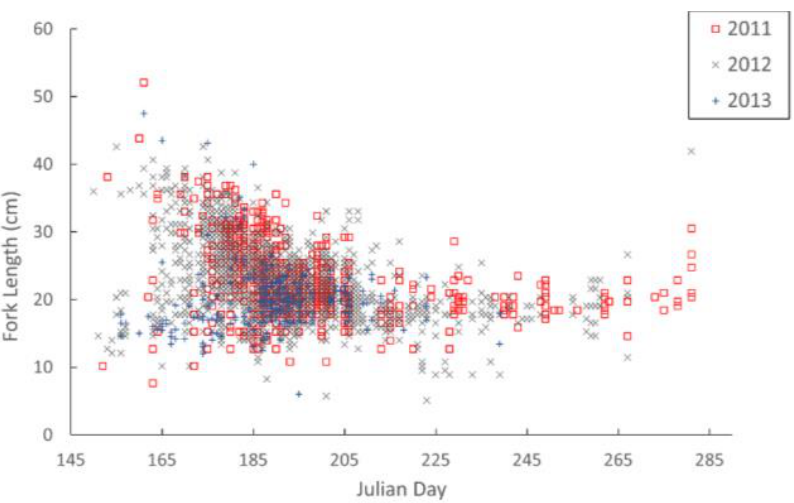
Figure 3. Size vs. timing of brook trout travelling upstream through the counting fence at Knox’s Dam on Montague River in 2011 (n = 853), 2012 (n = 2322), and 2013 (n = 239).